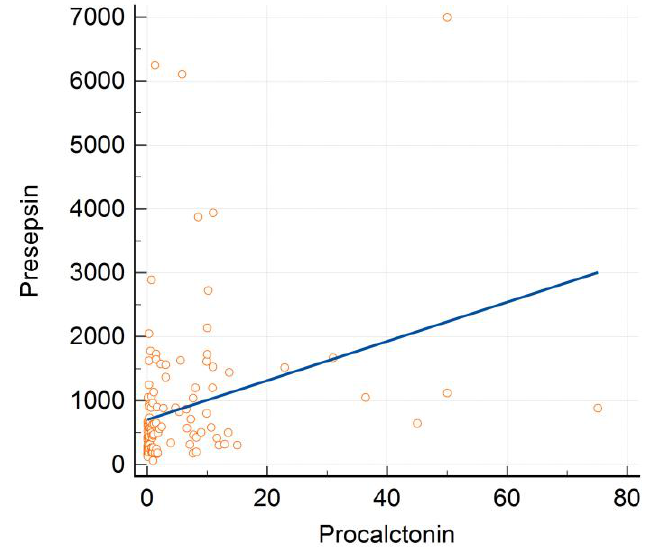
Figure 3. Correlation between procalcitonin and presepsin levels.